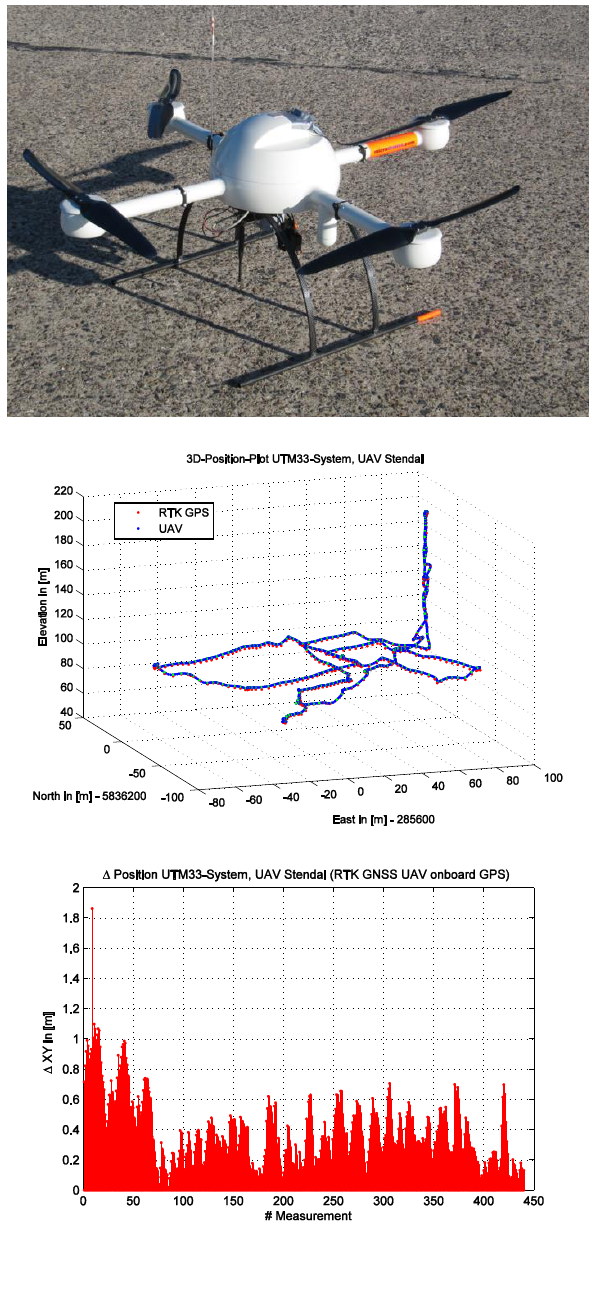
Figure 3, UAV GNSS 3D-Navigation (Comparison: Standard UAV GPS with the L1 RTK GNSS System)